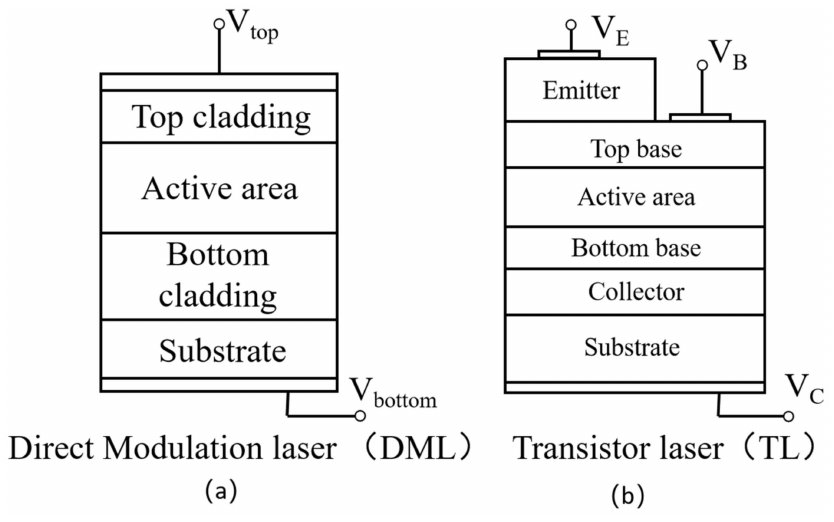
Figure 2. Structure diagram of traditional ( a ) directly modulated laser and ( b ) transistor laser.